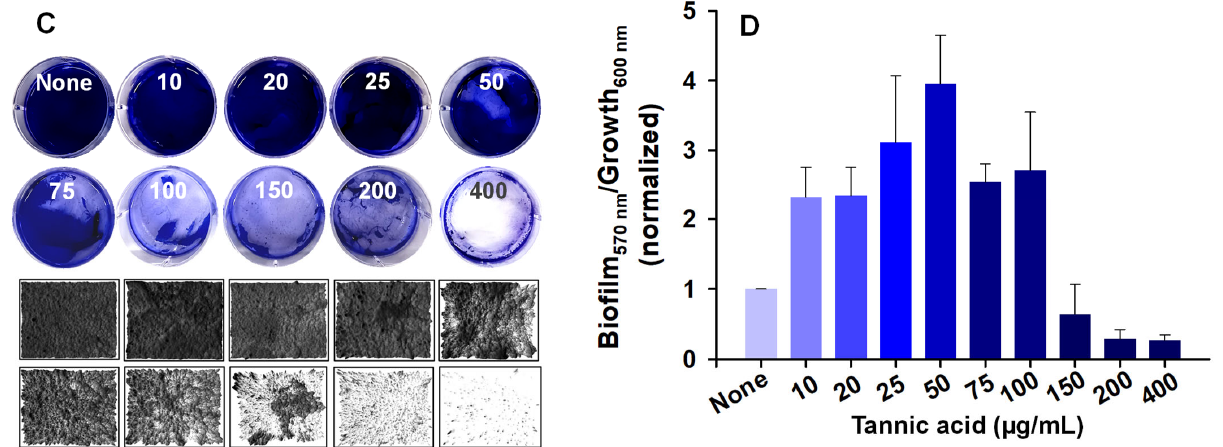
Figure 1. Tannic acid is composed of a central glucose with ten surrounding galloyl units ( A ). Biofilm formation of A. tumefaciens on polystyrene ( B ). Gross images and biofilm morphology on 6-well polystyrene plates ( C ). The normalized ratio of biofilm (Abs570 nm) to cell growth (Abs620 nm) shows tannic acid reduces biofilm formation at ≥ 150 µ g/mL ( D ). Cells were incubated in LB containing tannic acid at the concentrations shown for 48 h at 30 ◦ C under static conditions. Two independent bacterial colonies were used in triplicates ( n = 6) and experiments were repeated twice. Asterisks (*) denote significant differences ( p ≤ 0.05 by the two ‐ tailed t ‐ test) between treated groups and nontreated controls.